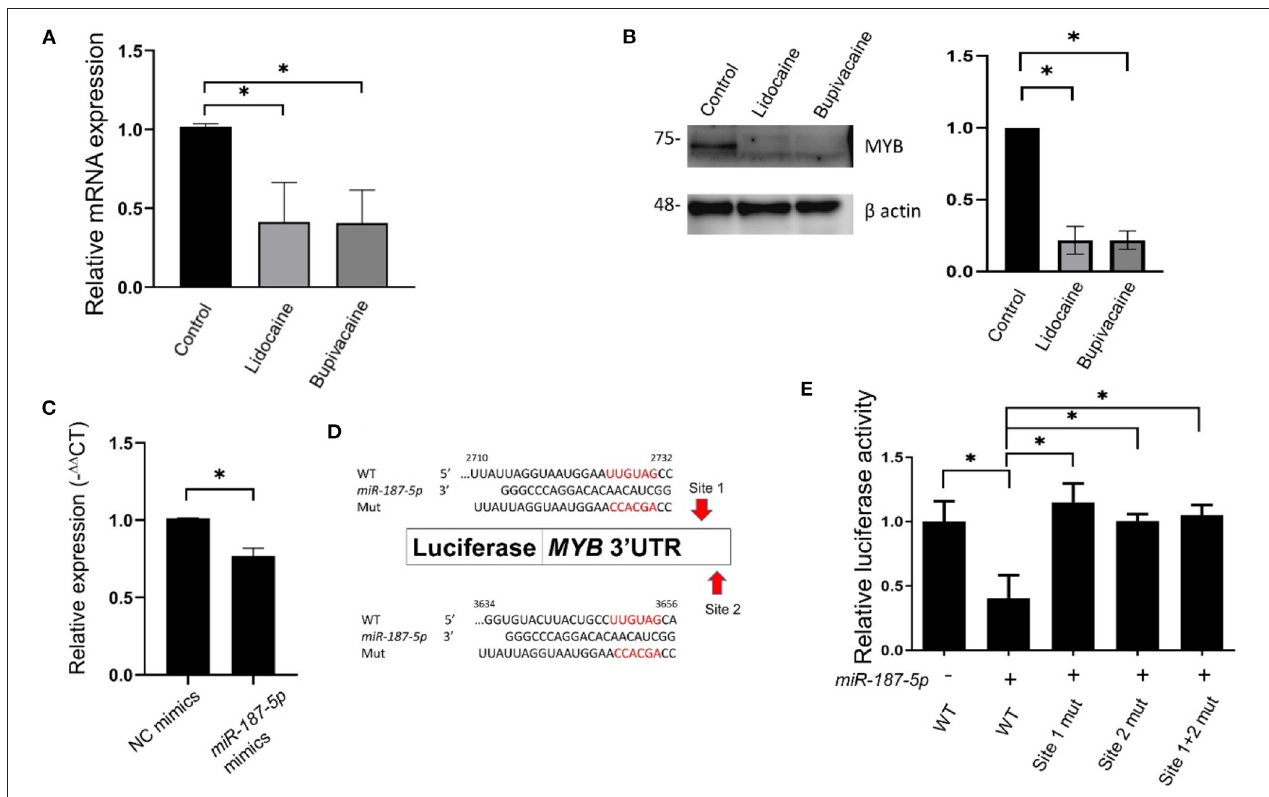
FIGURE 3 | Downregulation of MYB in MCF-7 cells following lidocaine and bupivacaine treatment. (A) The relative mRNA levels of MYB in MCF-7 cells following treatment with lidocaine (4mM) or bupivacaine (1mM). The expression levels of MYB were measured using qRT-PCR and normalised to that of 18S rRNA. (B) Western blots of MYB in MCF-7 cells following treatment with the LAs. Right: graphical representation of the results of western blotting. Left: quantification of the western blots. β actin was used as the loading control. (C) Relative expression levels of MYB in MCF-7 cells overexpressing miR-187-5p . The cells were transfected with 2 µ g of miR-187-5p or control mimics. The expression levels were detected using qRT-PCR and normalised to that of 18S rRNA. (D) Schematic diagram of the putative binding site of miR-187-5p in the 3 ′ -UTR region (2,493 ∼ 3,684 bp) of MYB . (E) Luciferase reporter assays of MYB 3 ′ -UTR in HEK-293T cells